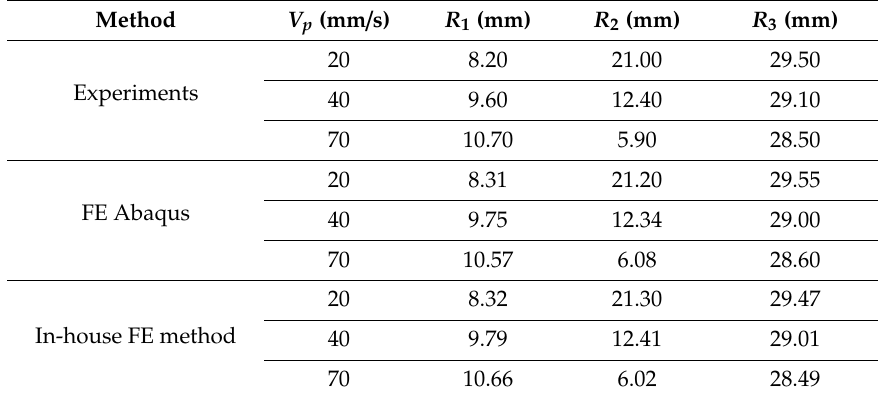
Table 4. Geometric parameters of the beams printed with different speeds after the heating–cooling process.